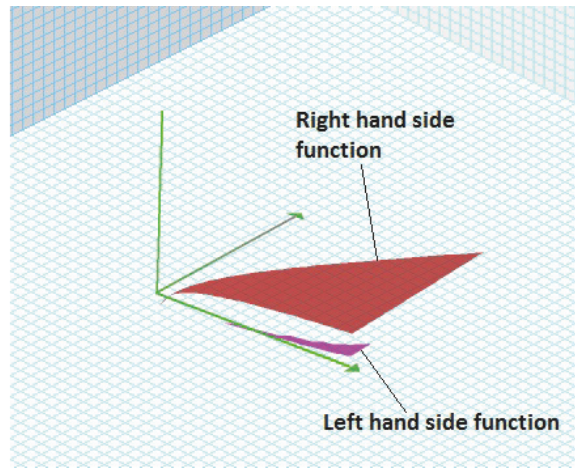
Figure 2: Right hand side is dominating left hand side in Case 2